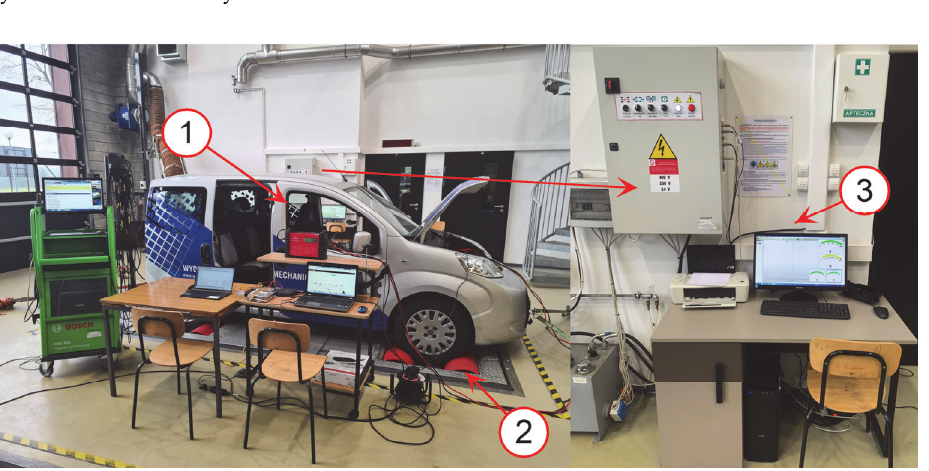
Figure 1. Test stand for testing a vehicle powered by different fuels. 1. Fiat Qubo vehicle under test. 2. DF4FS-HLS chassis dynamometer. 3. Computer with DynoRace software installed along with control cabinet and sensor accessories.